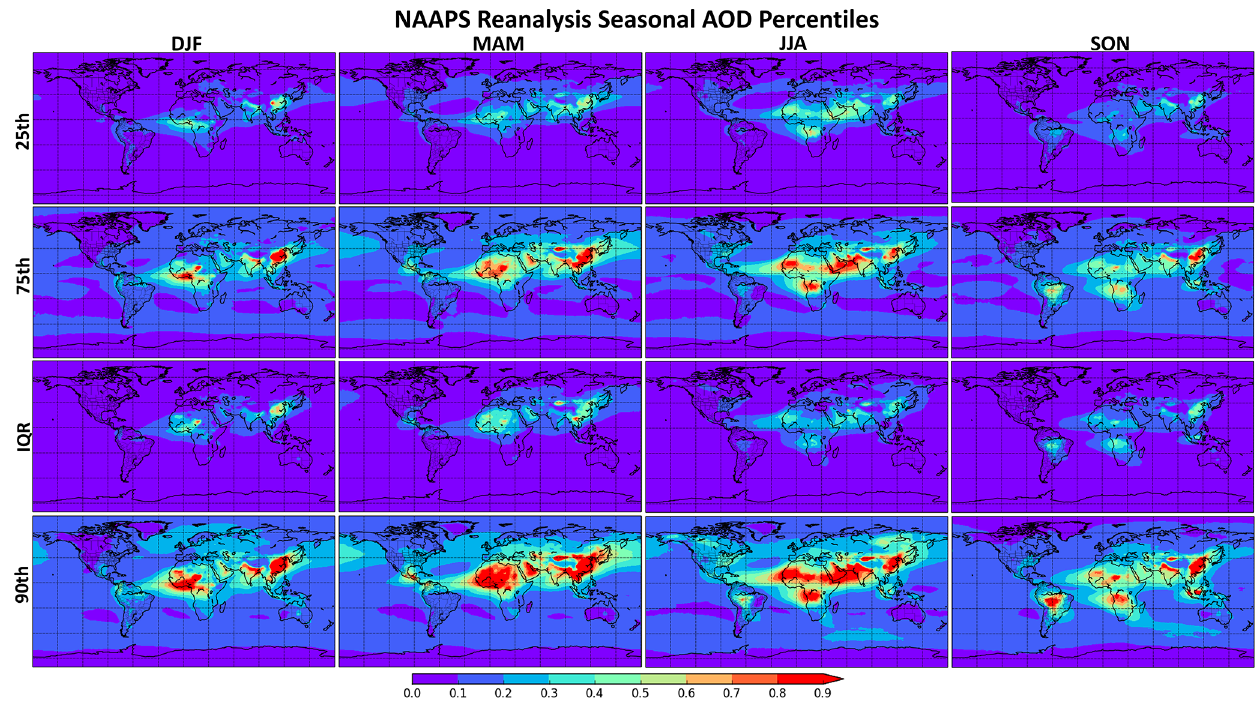
Figure 5. NAAPS-RA AOD percentiles by season (DJF, MAM, JJA, SON). The 25th and 75th percentiles are shown, along with the interquartile range (IQR). The 90th percentile is used to show high AOD values at a given